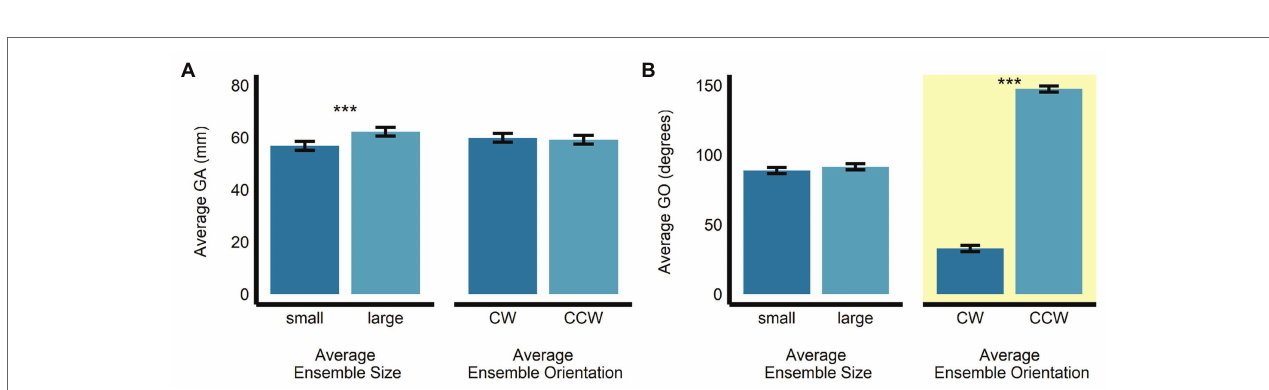
FIGURE 4 | Univariate results of the perceptual average orientation-discrimination task. Estimated marginal means of average (A) grip aperture and (B) grip orientation are given for the small and large average size ensemble displays, and for the CW and CCW average orientation ensemble displays. *** p < 0.0001; error bars depict SEM; GA, grip aperture; GO, grip orientation; CW, clockwise; CCW, counter-clockwise. Grip orientation was the grasp parameter most relevant to the orientation-discrimination task and is highlighted in